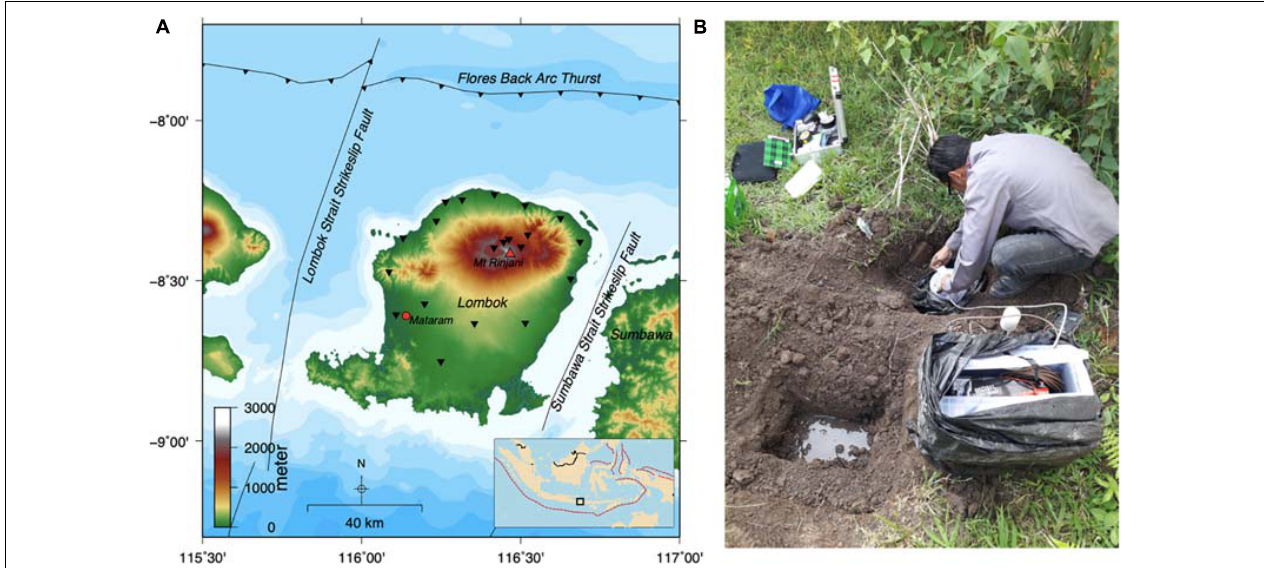
FIGURE 1 | (A) Map of Lombok, Indonesia showing 20 seismic stations used in this study. The black inverted triangle represents the station location while the red triangle represents the Rinjani Volcano. Black lines stand for active fault from Irsyam et al. (2017). (B) Temporary seismic station installation in the field.